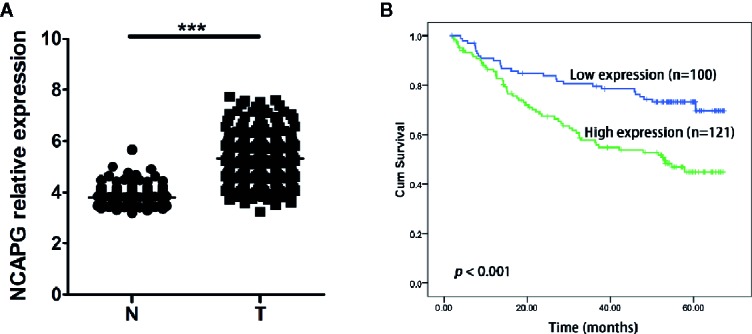
High NCAPG level correlated with poor survival in HCC. (A) Comparison of NCAPG expression between HCC cancer tissues and non-cancerous tissues with GEO dataset. The gene of NCAPG is significantly upregulated in HCC cancer tissues. N, normal; T, tumor. ***p < 0.0001. (B) Prognostic value of NCAPG mRNA expression with GEO dataset. Survival curves are plotted for patients with HCC. Compared with low NCAPG expression, the overall survival rates of patients with high NCAPG expression was lower. Blue color represents HCC patients with high NCAPG expression and green color represents HCC patients with low NCAPG expression. p < 0.001.